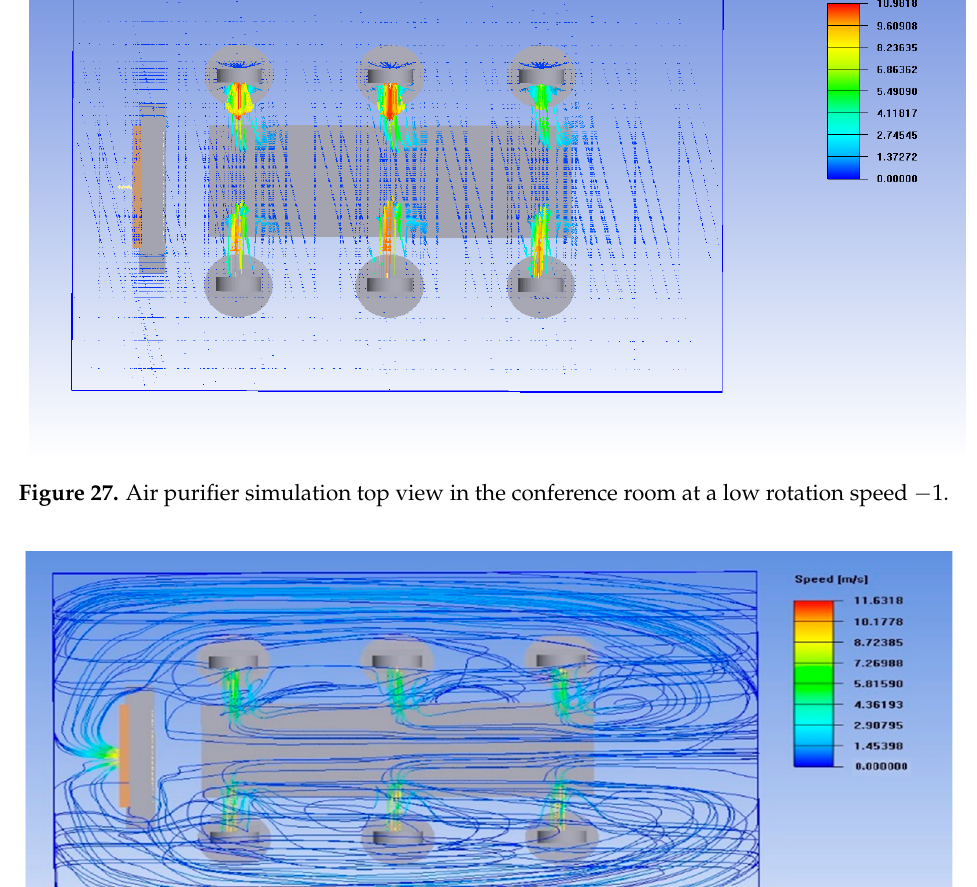
Figure 28. Air purifier simulation top view in the conference room at a low rotation speed -2.